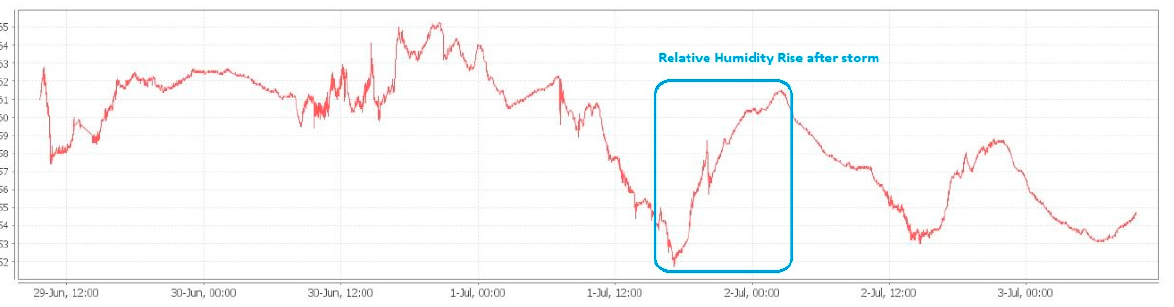
Figure 13. Local microclimate monitoring in LV/MV switchgear cells, increase in humidity after the storm of 1 July 2021.